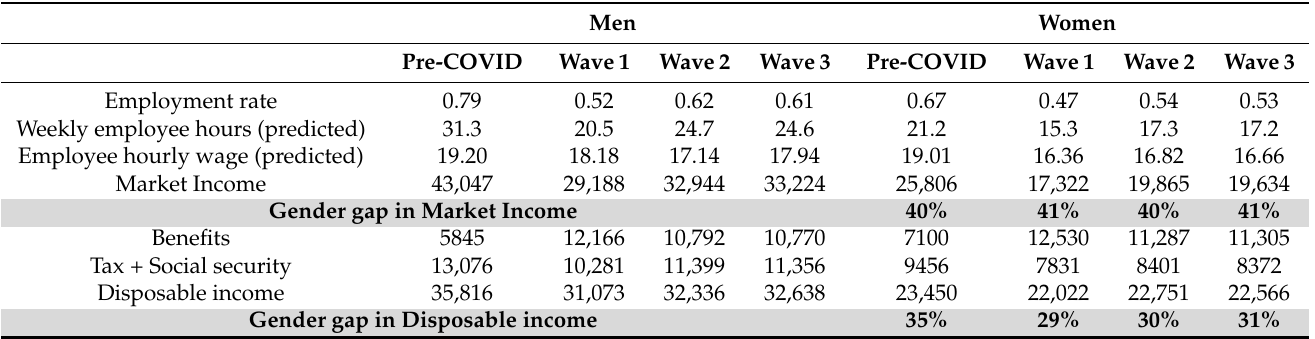
Table 1. Employment, wages and income pre-COVID and during the three waves of the pandemic by